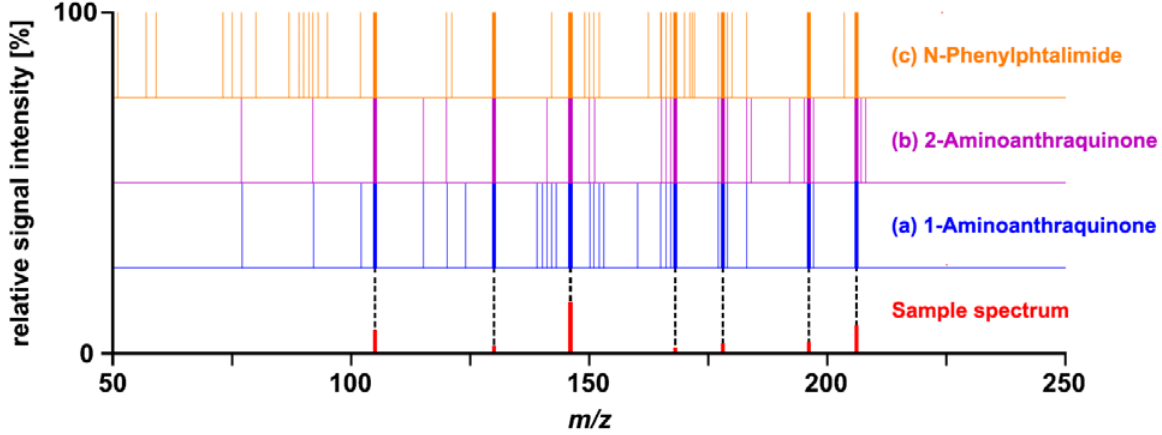
Figure 2. Comparison of the sample spectrum provided for Challenge 10 with the merged spectra of ( a ) 1-aminoanthraquinone, ( b ) 2-aminoanthraquinone, and ( c ) N-phenylphthalimide. Each line in the merged spectra represents a fragment ion; the corresponding signal intensities are not